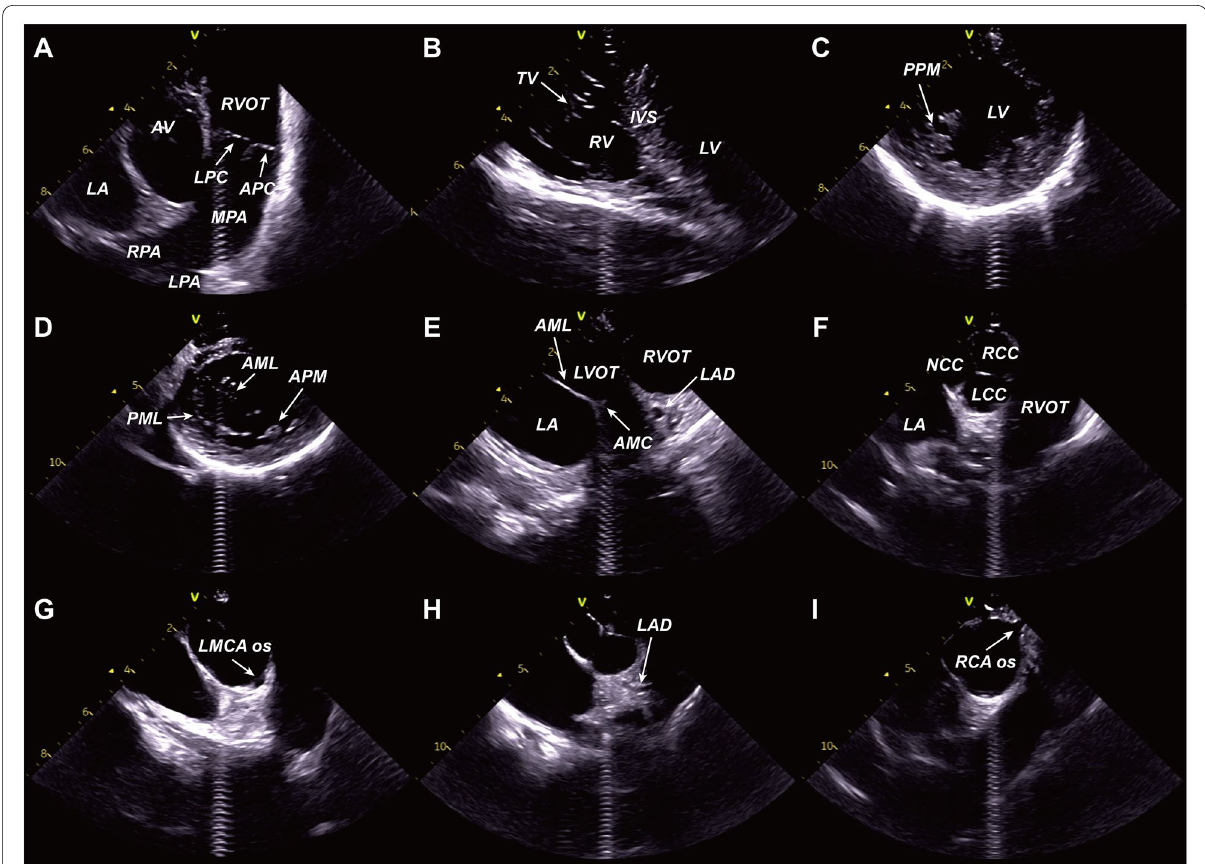
Fig. 2 Assessment of the ventricular outflow tracts from the right ventricle. A. RVOT and pulmonary artery. B. RV, LV, and interventricular septum (IVS). C. Posteromedial papillary muscle (PPM). D. Mitral leaflets and anterolateral papillary muscle (APM). E. Aorto‑mitral continuity (AMC). F. Three aortic valve (AV) cusps. G. Left main coronary artery (LMCA) ostium (os). H. Tracking of the left anterior descending artery (LAD). I. Right coronary artery (RCA) ostium. RVOT, right ventricular outflow tract; LPC, left pulmonary cusp; APC, anterior pulmonary cusp; MPA, main pulmonary artery; RPA, right pulmonary artery; LPA, left pulmonary artery; LA, left atrium; TV, tricuspid valve; RV, right ventricle; LV, left ventricle; AML, anterior mitral leaflet; PML, posterior mitral leaflet; RCC; right coronary cusp; LCC; left coronary cusp; NCC, non‑coronary